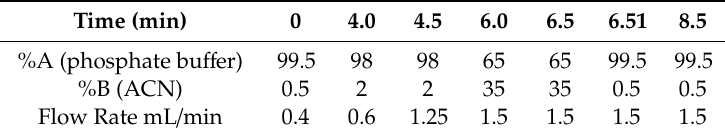
Table 2. Chromatography conditions.